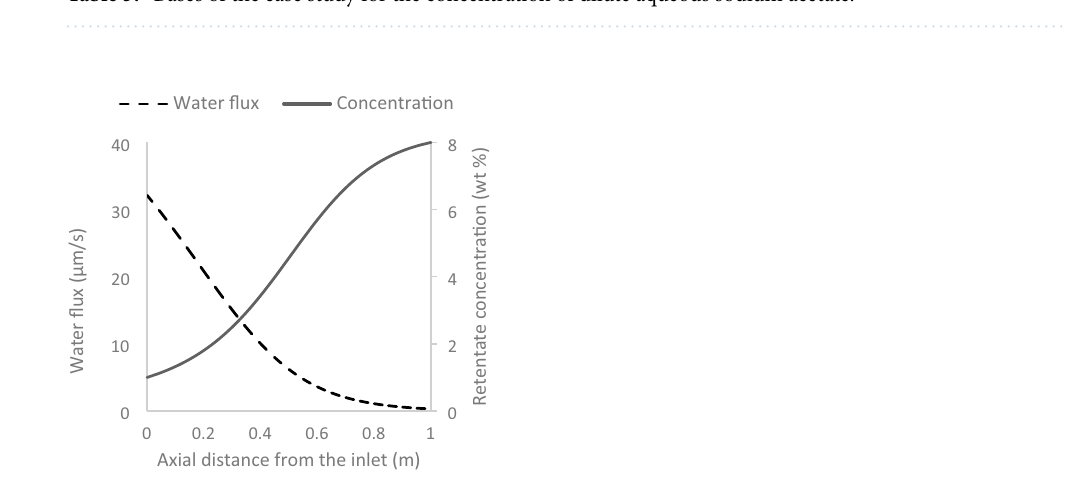
Figure 5. Concentration and flux profiles along the length of the modules, for RO-1, corresponding to the bases of the case study, in Table